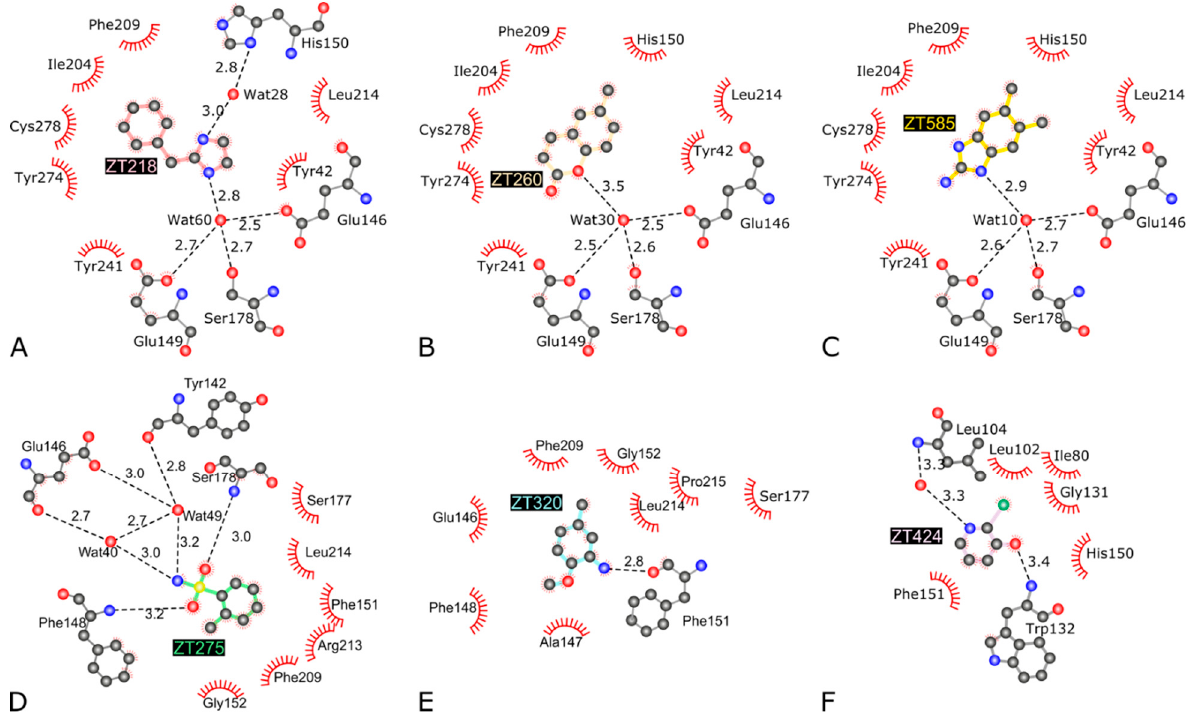
Figure 4. 2D interaction maps of fragments ZT218 ( A ), ZT260 ( B ), ZT585 ( C ), ZT275 ( D ), ZT320 ( E ), and ZT424 ( F ) bound to the Hma protein. Hydrogen bonds are represented with dashed black lines and their lengths are indicated. Residues/atoms involved in van der Waals contacts are represented by notched semicircles (figure adapted from LigPlot+ [34]).